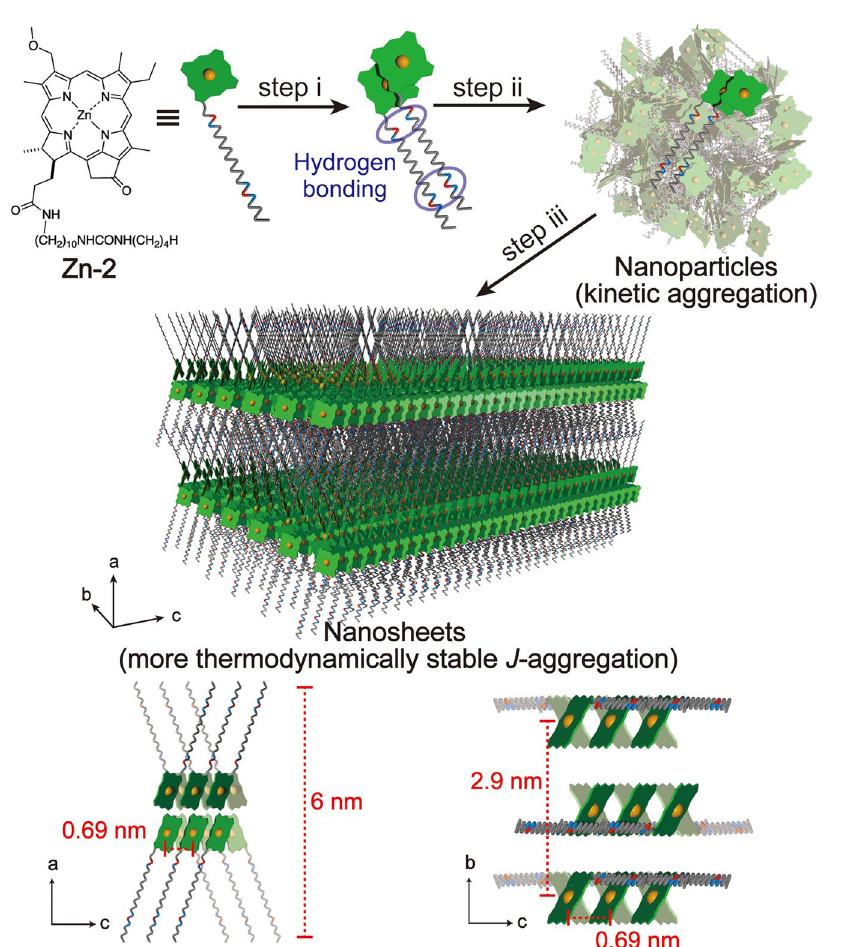
Figure 6. Schematic drawing of the Zn-2 chlorosomal J -aggregation